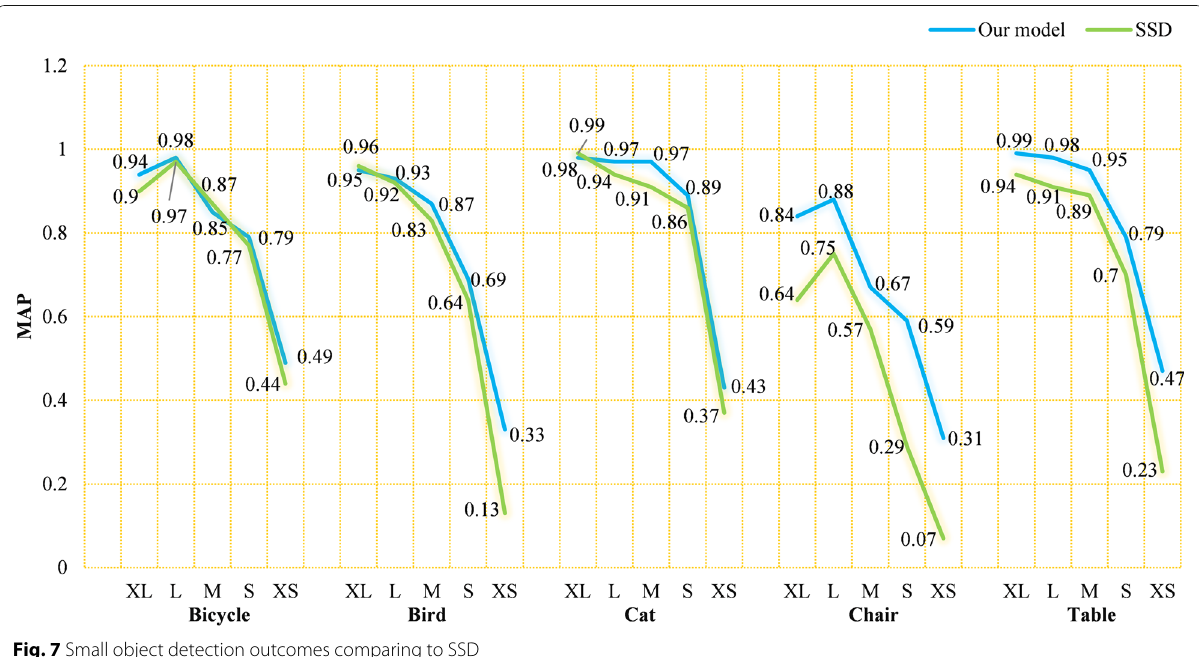
Fig. 7 Small object detection outcomes comparing to